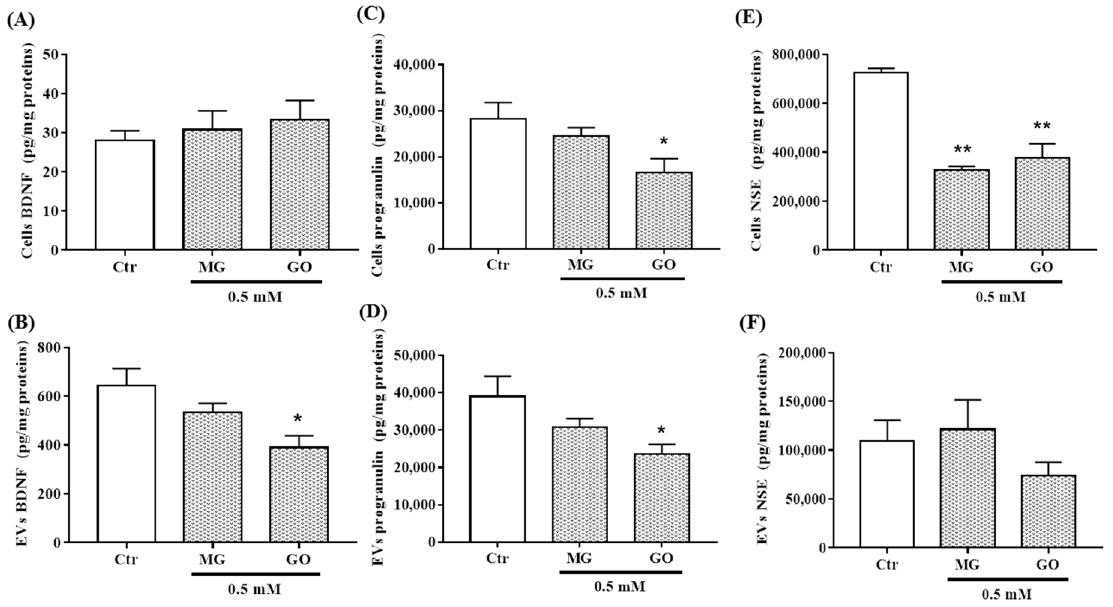
Figure 5. BDNF, PRGN and NSE levels in nEVs and in SK-N-SH cells exposed or not to MG and GO. The level of each marker was normalized using total protein concentration. The bar graphs showBDNF, PRGN and NSE levels in SK-N-SH cells ( A , C , E ) and in / on EVs ( B , D , F ). Values are mean ± S.E.M (from three separate experiments) and data groups were compared with one-way ANOVA followed by the Dunnett’s post hoc test. * p < 0.05, ** p < 0.01 versus control cells.